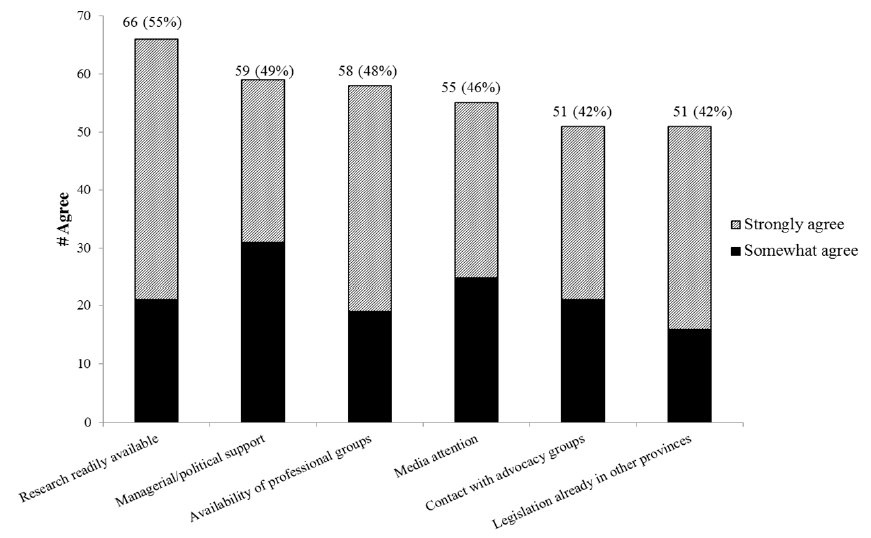
Figure 4. Legislation (all topics) as it currently stands has been instituted in my province because….